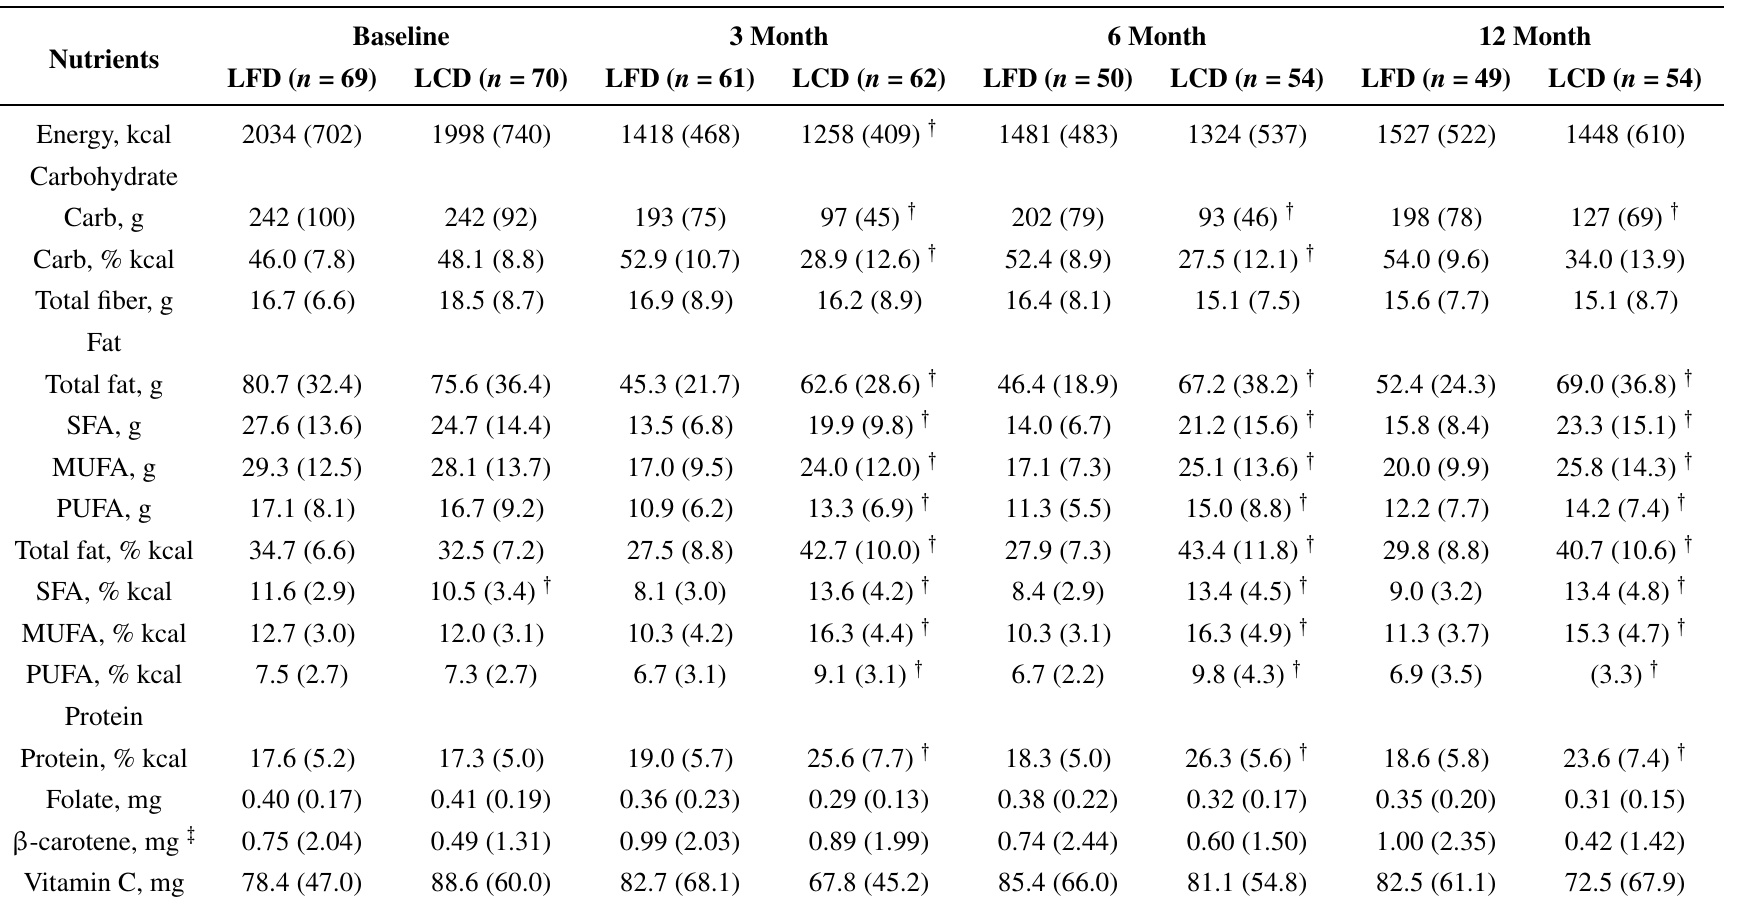
Table 2. Daily dietary composition in the low-fat and low-carbohydrate diet groups over the course of the study * .